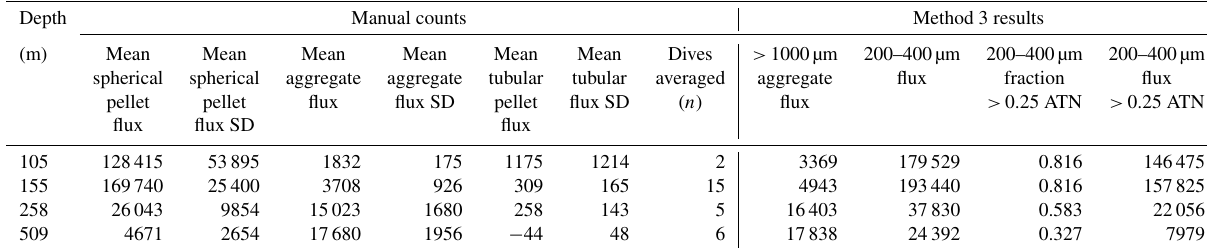
Table A1. Comparison of pellet and aggregate flues from manual enumeration and from particle analysis method 3.